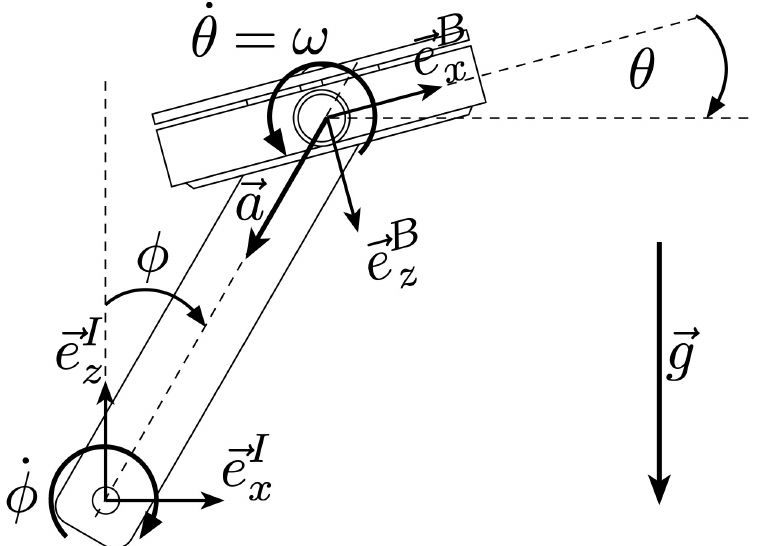
Figure 5. Pedal kinematics modeling. Annotated definition of the world frame I , body frame B , crank angle φ and pedal angle θ . Note that the pedal angle θ is defined with respect to the world- horizontal plane (perpendicualr to the gravity vector (cid:126) g ) and is independent of the crank-angle φ . The gyroscope measures the pedal’s angular rate ˙ θ = ω , while the accelerometer measures the pedal’s acceleration biased by gravity B ¨ (cid:126) x = B (cid:126) a + B (cid:126) g . Please also note that both frames of reference I and B are 3D orthonormal, right-handed frames, with their y -axis pointing inward and outward respectively. These axes are not depicted in the image to avoid overcrowding. The pedal’s motion is mechanically constrained to the xz -plane, and it can thus be assumed, without loss of generality, that the y -position of the pedal is constant at